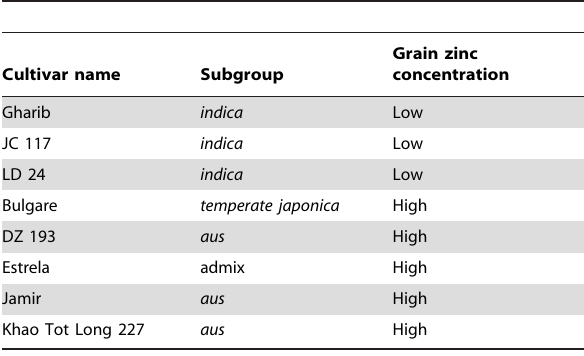
Table 2. Cultivars which were in either the upper (high grain zinc) or lower (low grain zinc) 20% in all of the five field trials.